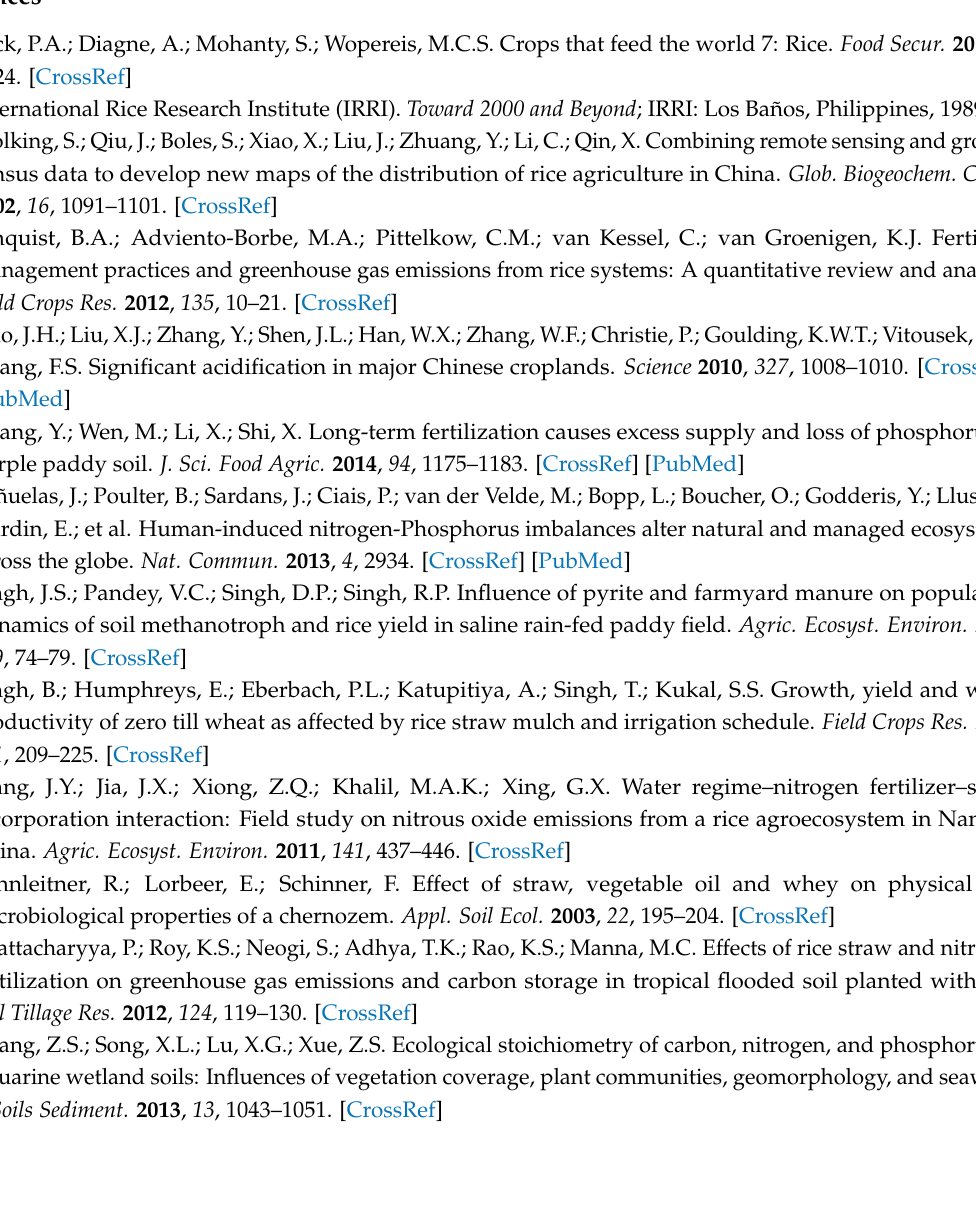
Figure A3. Standardized canonical scores distribution along the root resulting from the discriminant general analysis with the straw and soil variables as independent continuous variables, the days of sampling as an categorical independent variable, and different grouping-dependent factors corresponding to the habitats (ridges and ditches) where straw was applied.